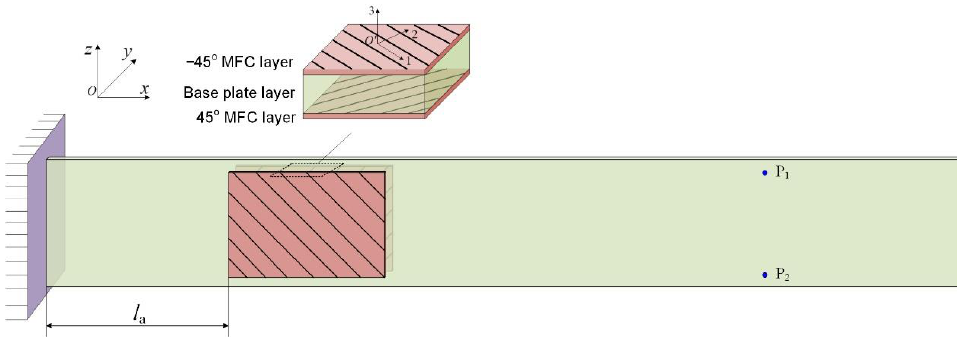
Figure 1. Schematics of the MFC-actuated compliant plate structure. Because the laser displacement sensors were used to measure the elastic deformation, two measurement points, which were symmetrical relative to the midline, as shown in the figure, were chosen to represent the bending and twisting deformations. The optimization of the locations of the MFC actuators is described in the following sections. Table 1. The geometric and material properties (theoretical value) of plant. Parameters